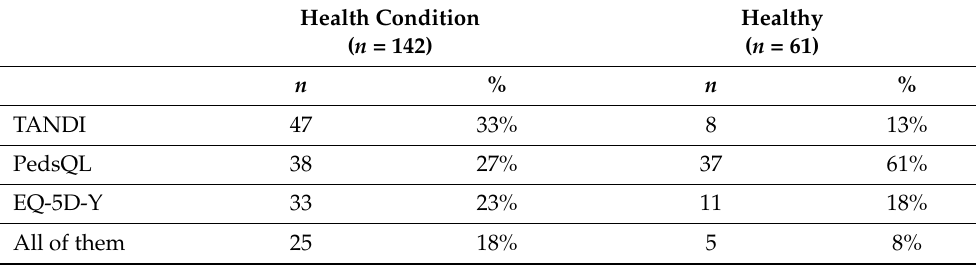
Table 5. Questionnaire which best described the health state of the child with and without a health condition. (Total Sample N = 203). Health condition indicates attendance at a paediatric hospital for management of an acute or chronic health